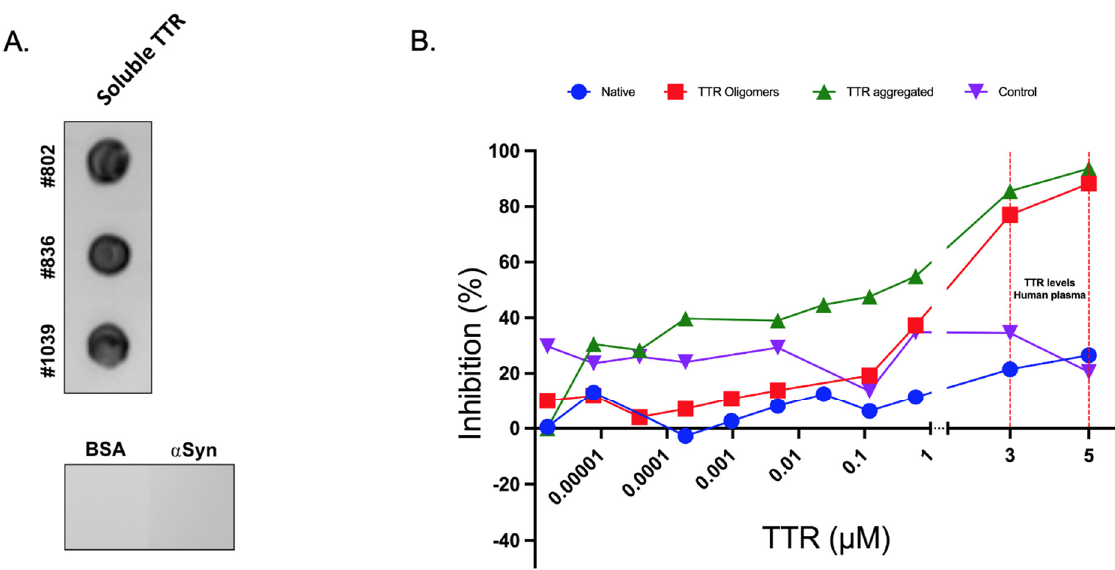
Figure 1. Binding of Ab-A to native, oligomeric and aggregated TTR. ( A ) Ab-A was tested for binding purified soluble TTR from human heart extract. Dot blot of mAb-A antibody to soluble TTR. BSA and alpha synuclein were blotted as negative control. ( B ) Binding of Ab-A to TTR Native, Soluble TTR oligomers or aggregated TTR and the consequent interaction inhibition of Ab-A to the aggregated TTR. BSA red lines illustrate the levels of endogenous TTR in human plasma. One representative result out of three is shown.